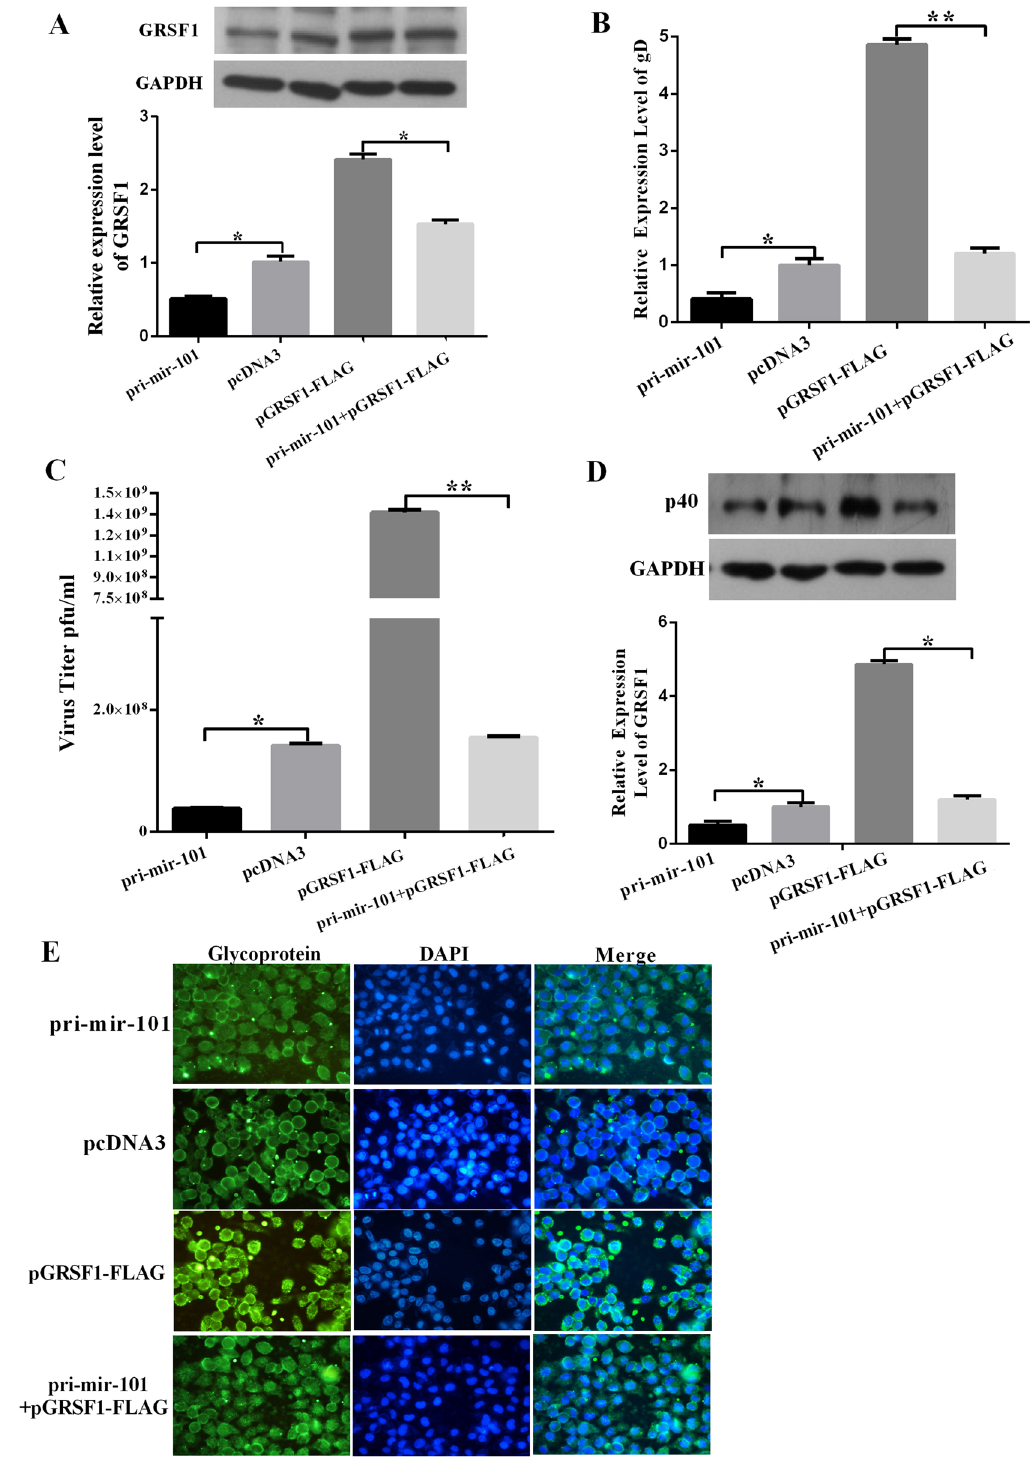
Figure 6. Overexpression of GRSF1 rescues the replication of HSV-1 that was repressed by pri-mir-101 in HeLa cells. ( A ) The overexpression of GRSF1 rescues the replication of HSV-1 that was repressed by pri-mir-101. HeLa cells were transfected with pcDNA3, pri-miR-101, or GRSF1-FLAG or were co-transfected with GRSF1-FLAG and pri-mir-101. GRSF1 protein levels were detected by Western blot. GAPDH protein was used as an endogenous control, and the relative quantity of GRSF1 protein is shown. ( B–D ) The overexpression of GRSF1 rescues the repression of HSV-1 replication that was caused by pri-mir-101. HeLa cells were transfected with pcDNA3, primiR-101, or GRSF1-FLAG or were co-transfected with GRSF1-FLAG and pri-mir-101. ( B ) The expression level of the gD gene was detected by qPCR. ( C ) Viral plaques in HeLa cells and ( D ) Western blot demonstrating HSV-1 replication in the presence of p40; GAPDH protein was used as an endogenous control. ( E ) Immunofluorescence was used to detect HSV-1 replication using an HSV-1 membrane protein in HeLa cells. *P <